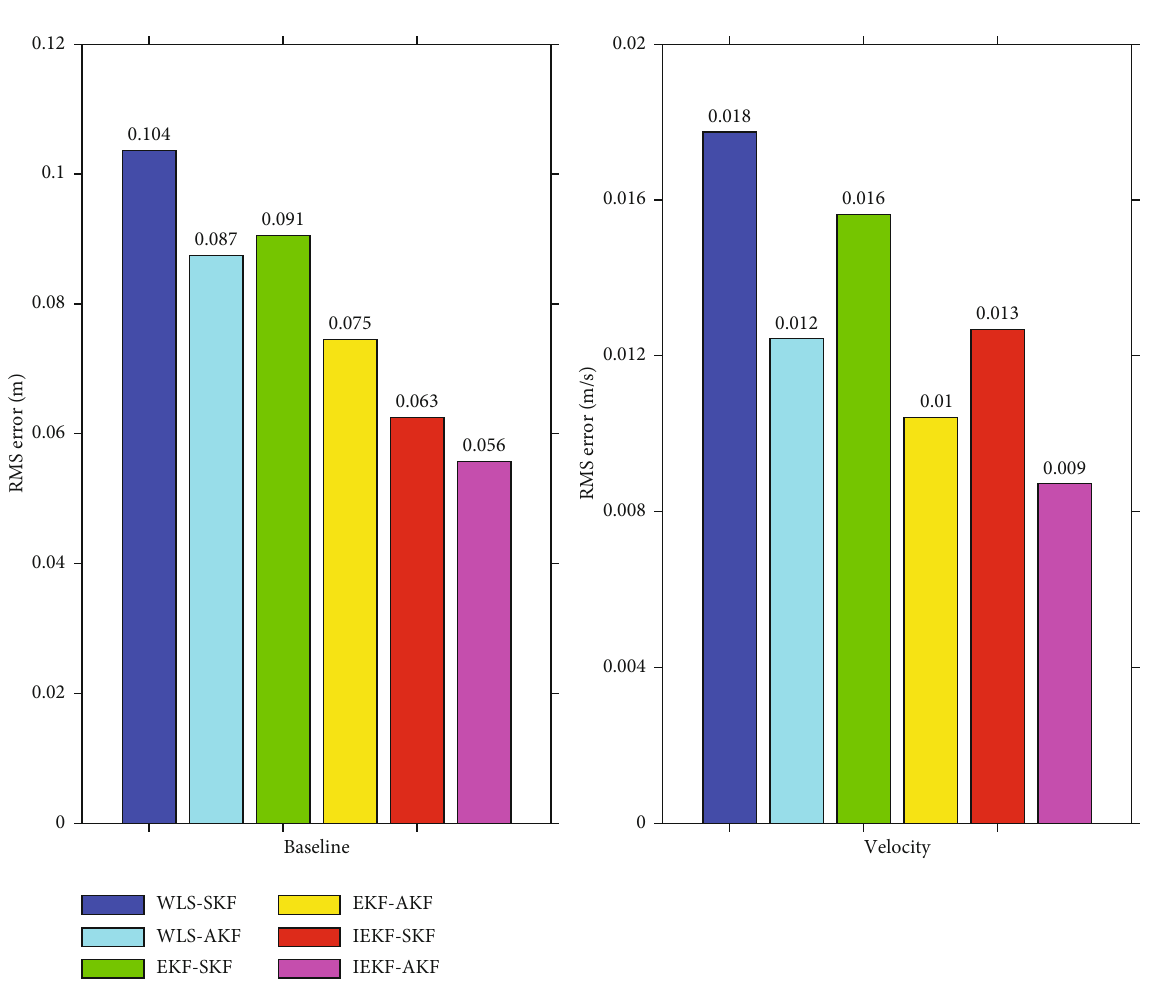
Figure 15: The RMS errors of baseline and velocity of various algorithms (Data